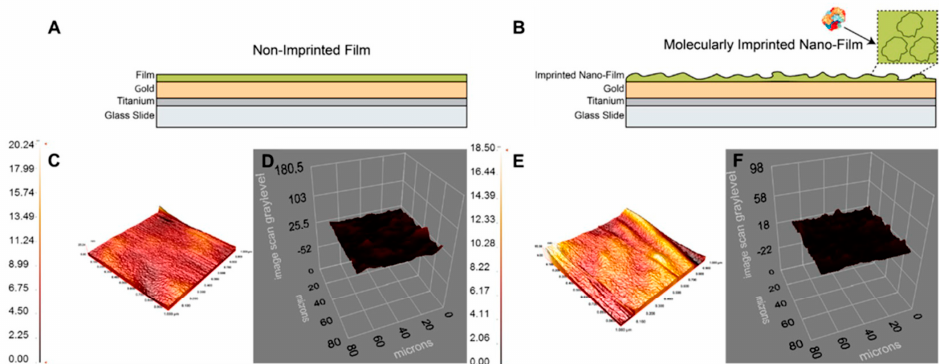
Figure 4. AFM and ellipsometer images of the NIP ( A , C , D ) and MIP ( B , E , F ) nanofilms. Reprinted from [77] with permission from Saylan et al.